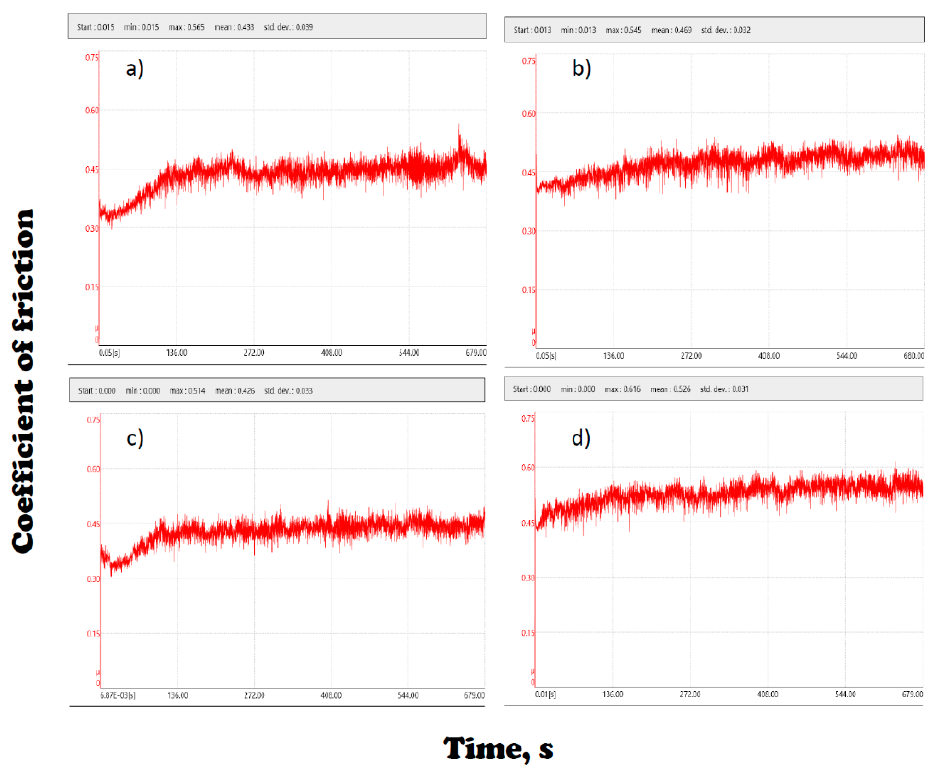
Figure 25. Wear curve for Ti solid 4 ( a , b ) and Ti solid 8 ( c , d ): ( a , c ) specimen side and ( b , d ) single-layer on specimen front.